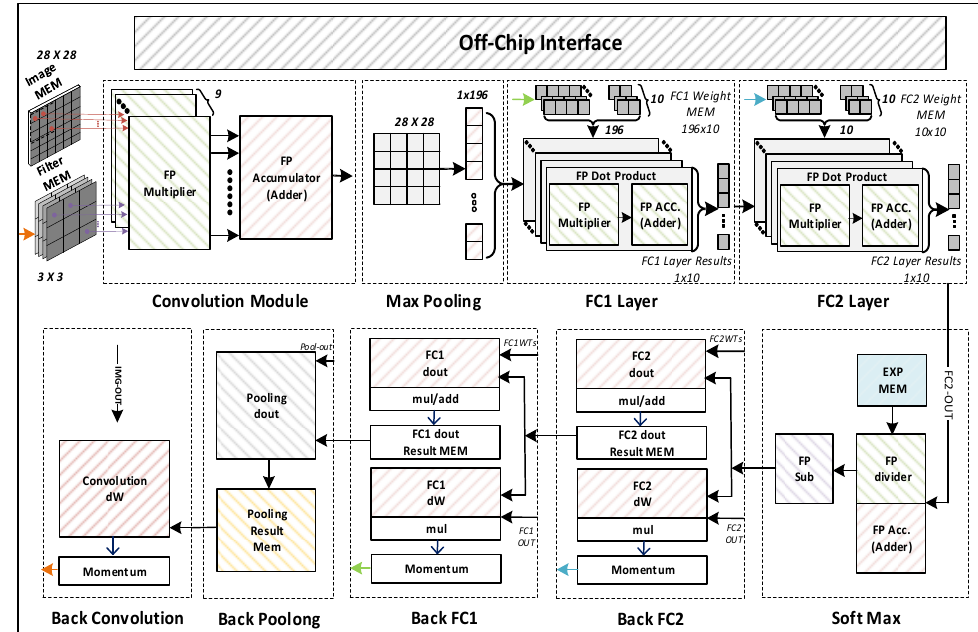
Figure 9. Overall architecture of the proposed CNN accelerator.